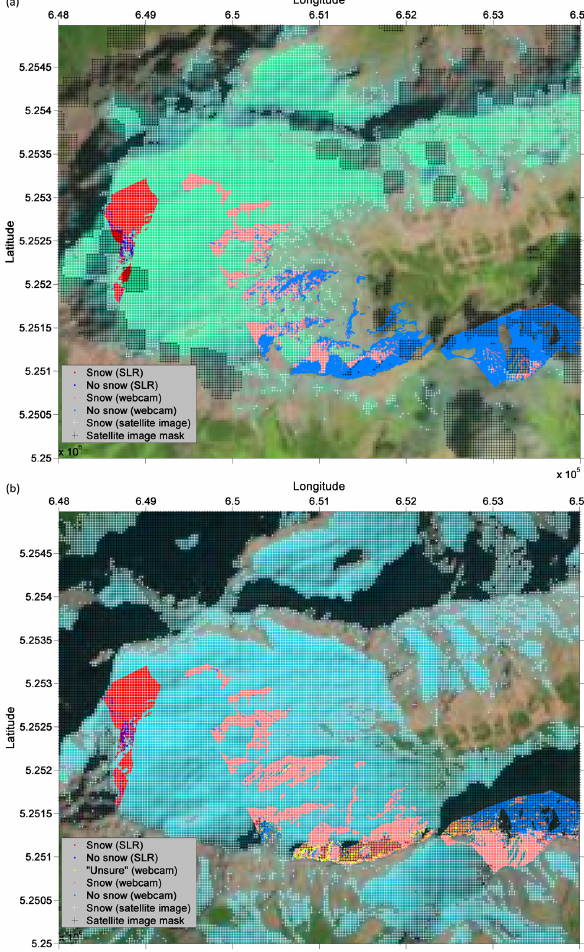
Figure 12. Resulting snow cover maps of the SLR and webcam photographs, and the Landsat images for the Zugspitze massif su- perimposed on the Landsat Look images: the satellite snow cover maps are calibrated using the SLR snow cover maps as baseline. The resulting NDSI thresholds are 0.35 for 1 July 2013 (a) and 0.23 for 7 April 2014 (b) . Snow cover in the satellite data is illustrated with white crosses, masked areas with black crosses mainly due to clouds in (a) and shadows in (b) . Pixels not superimposed with crosses are areas classified as free of snow in the satellite images. The photograph snow cover maps display snow and no snow in red and blue for the SLR and in light red and light blue for the webcam. Unsure snow classification results only occur for the photographs on 7 April 2014 (b) as the PCA-based classification routine is ap- plied and are only shown for the webcam (yellow) as the percentage of unsure snow classifications in the SLR photograph (Figs. 10c and 11a) is